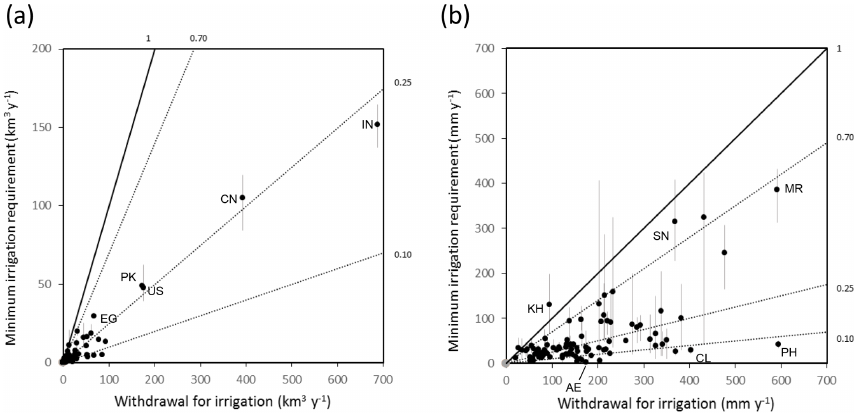
Figure 6. Comparison of country-level agricultural water withdrawal ( W) (FAO, 2017) and estimated minimum irrigation requirement ( I 0 ) expressed as (a) total volume and (b) depth per unit area of area equipped for irrigation for countries with > 1km 3 yr − 1 withdrawals ( N = 91). Dotted lines show apparent project efficiencies between the two quantities. Countries indicated in ( a ) are Egypt (EG), Pakistan (PK), United States (US), China (CN) and India (IN), and in ( b ) Cambodia (KH), Senegal (SN), Mauritania (MR), United Arab Emirates (AE), Chile (CL) and the Philippines